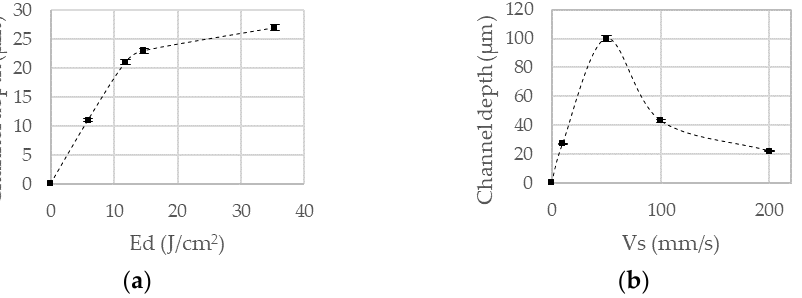
Figure 1. Channel depth: ( a ) For different Ed at Vs = 10 mm/s; ( b ) For different Vs at Ed = 35.37 J/cm 2 . This surface modification may also be measured using roughness parameters. The deviation of the results is lower than 2%, which is difficult to be appreciated in the figure.